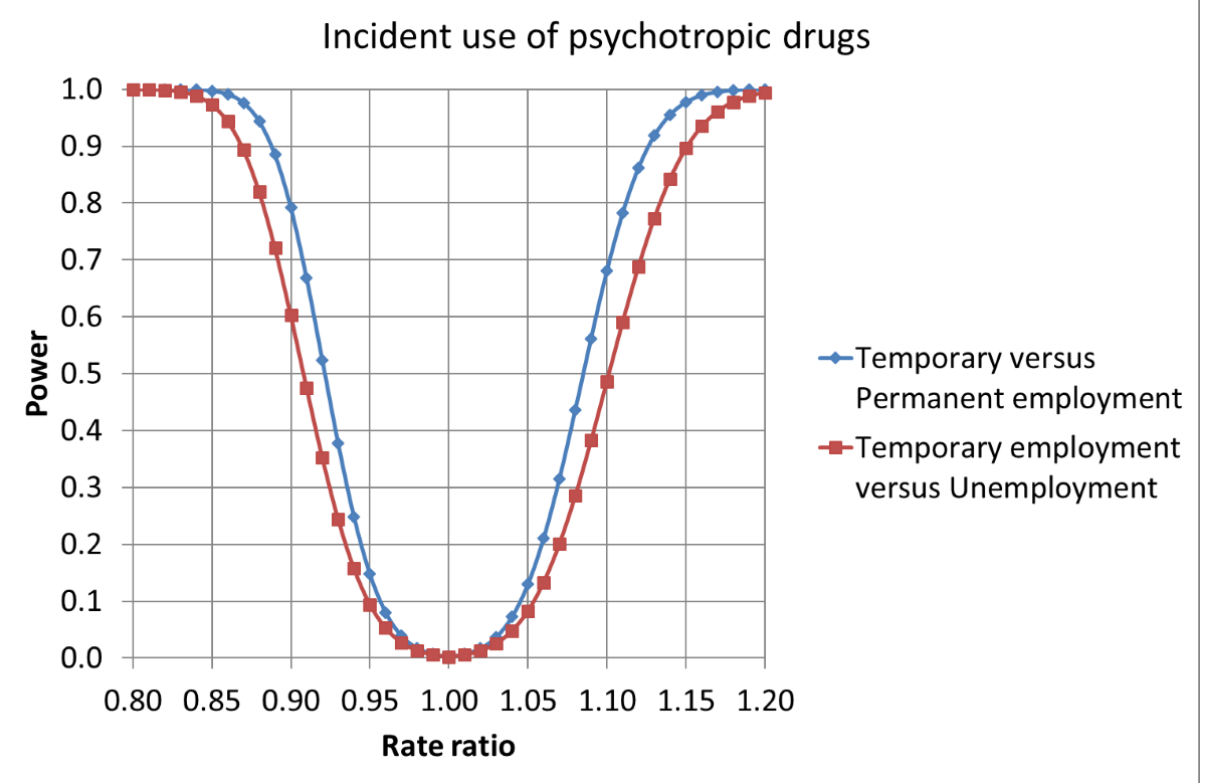
Figure 1. Power to detect main effects of fixed-term contracts on the rates of new cases of psychotropic drug use, as a function of underlying rate ratios ( α =.005).